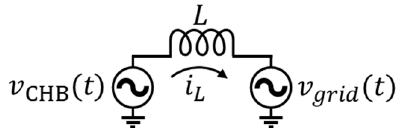
Figure 5. Model of a monophasic CHB grid-tied inverter.